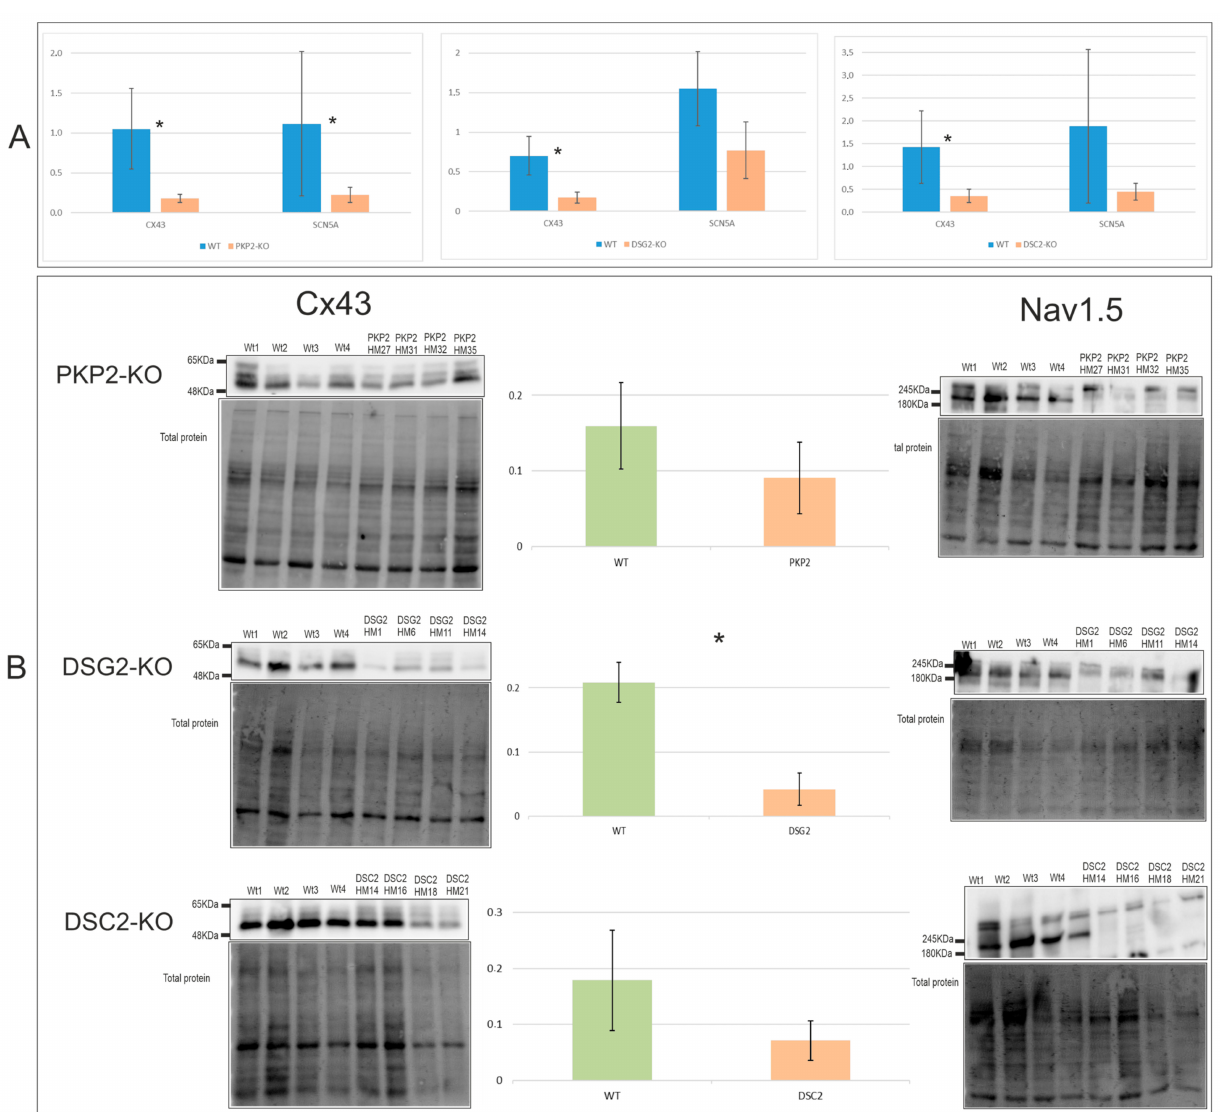
Figure 4. Cx43 and SCN5A expression at the mRNA ( A ) and protein ( B ) levels of the three KO groups PKP2 -KO, DSG2 -KO, and DSC2 -KO. * Indicates parameters that were significantly different compared with WT clones; p -value <0.05, see Table S4. Number of experiments: RT-PCR = 1; WB =